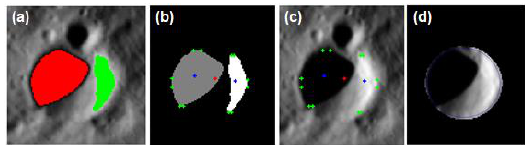
Figure 5. The example of automatic crater mask detection for the selected area of interest: (a) B (green) and D (red) regions; (b) and (c) crater’s center (red), centroids (blue) and extrema (green) of B and D regions; (d) ellipse inscribed in the detected extrema (crater’s mask) Figure 6 shows the detected crater mask (Figure 4 – are no.